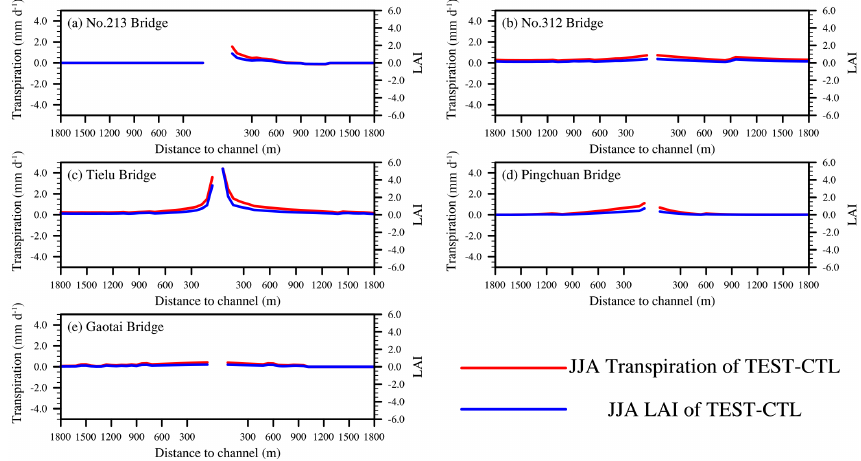
Figure 16. Differences between canopy transpiration and leaf area index predicted by TEST and CTL simulations during summer along the five sections at (a) 213 Bridge, (b) 312 Bridge, (c) Tielu Bridge, (d) Pingchuan Bridge, and (e) Gaotai Bridge. The discontinuous parts of the curves represent the river